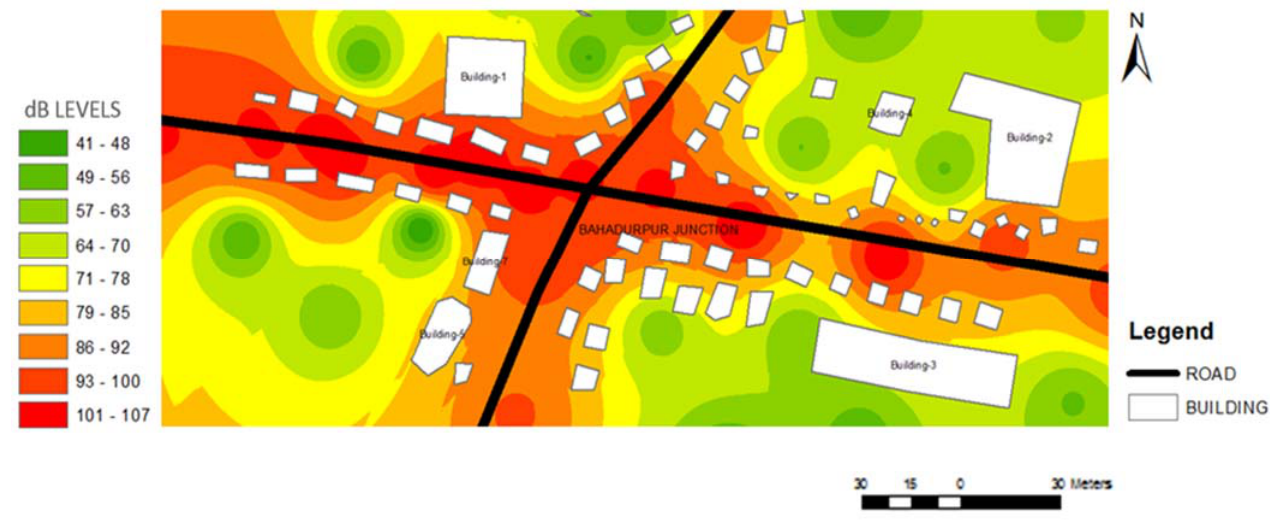
Figure 14. Predicted Leq noise map for daytime 7am to